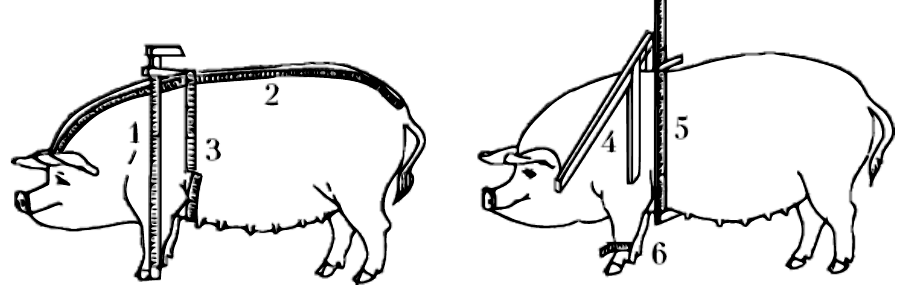
Figure 2. Picture of six measured body dimensions of a pig: (1) body length, (2) chest girth, (3) withers height, (4) chest depth, (5) chest width, and (6) metacarpus